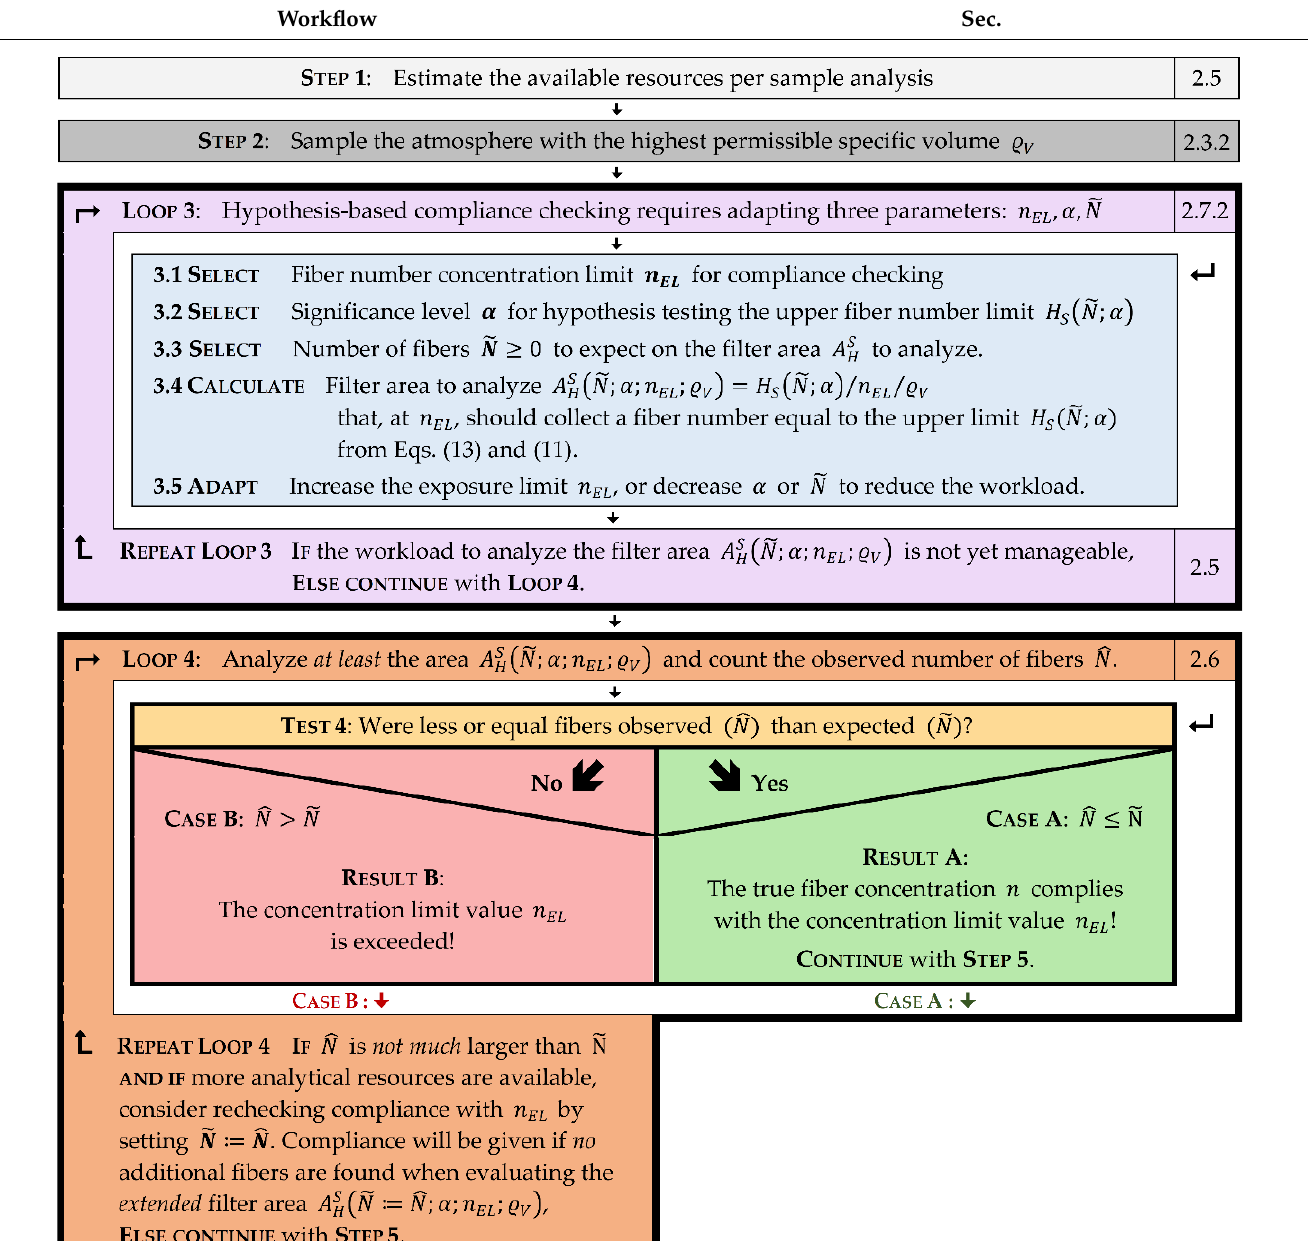
Table 11. Data evaluation workflow schematized as Nassi-Shneiderman-like diagram.